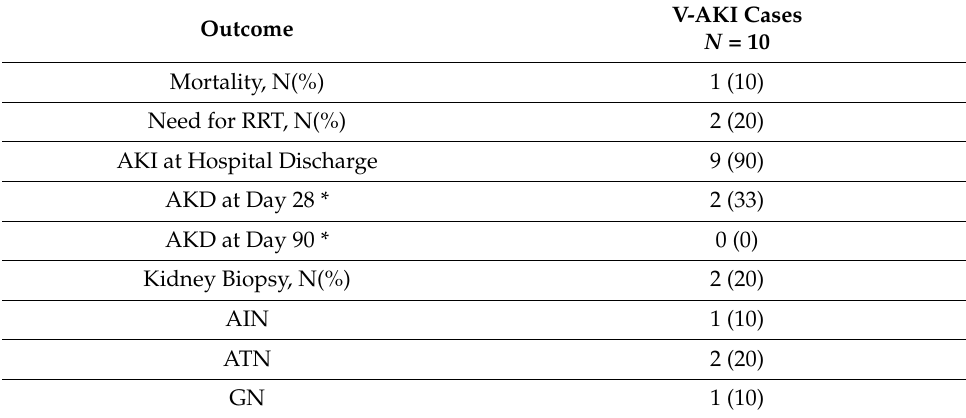
Table 2. Kidney Outcomes after V-AKI. * Scr was measured in six6 patients at 28 days post injury and four patients at three months post injury. Abbreviations: AIN—allergic interstitial nephritis; AKD—acute kidney disease; ATN—acute tubular necrosis; GN—glomerulonephritis; RRT—renal replacement therapy.